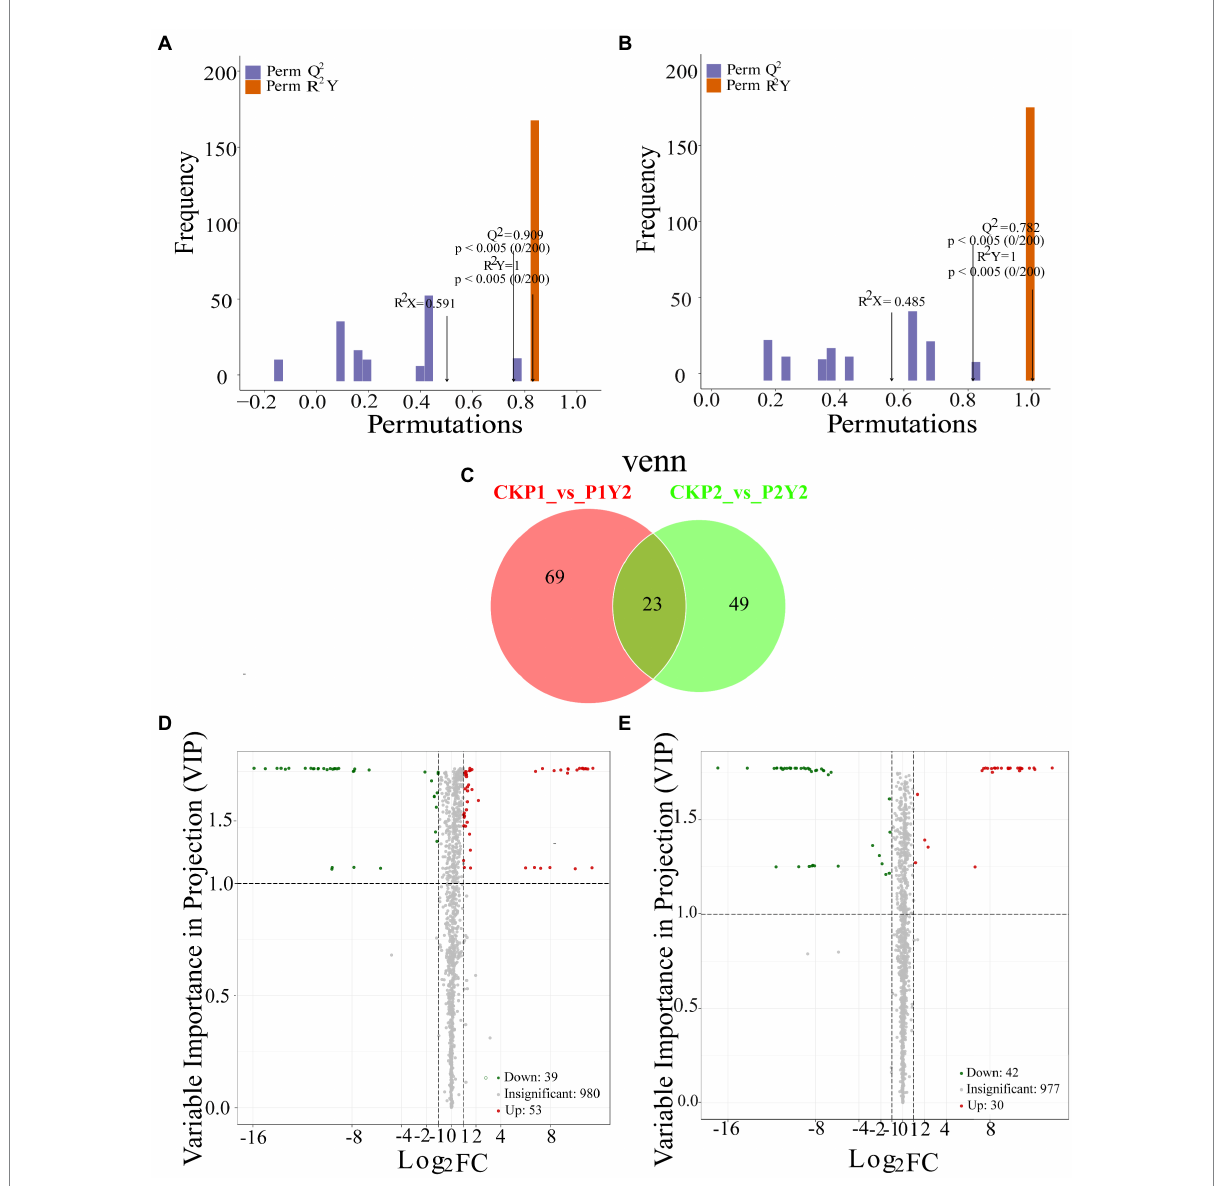
FIGURE 3 Differential analysis of metabolites in Se-enriched mung beans. OPLS-DA model plots of Se-enriched mung bean (A,B) . Venn diagrams showing the overlapping and specific differential metabolites (C) . Volcano plots showing the differences in the expression levels of metabolites in Se- enriched mung beans, red spots indicate upregulated differentially expressed metabolites; green spots indicate downregulated differentially expressed metabolites, and grey spots indicate detected metabolites, the differences were not significant at p < 0.05 (D,E)